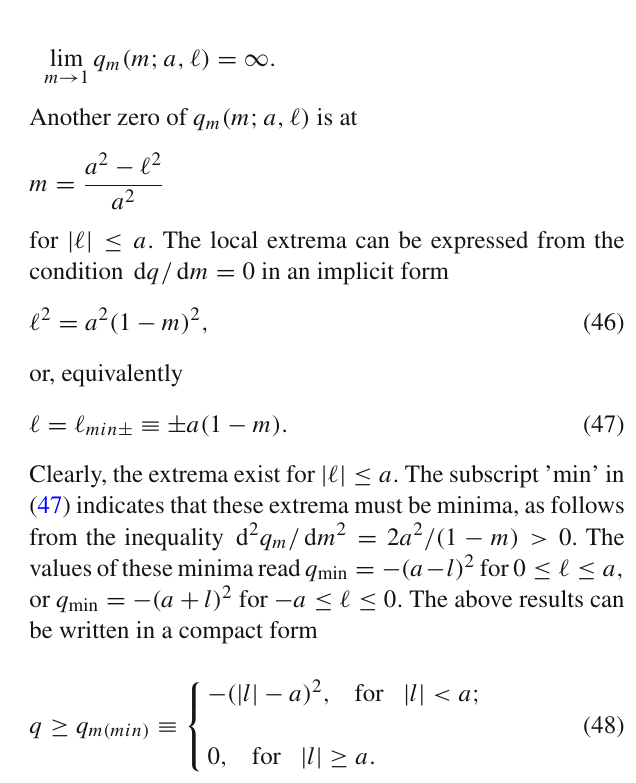
Fig. 4 Typical behaviour of the function q m ( m ; a ,(cid:11)) for appropriately chosen values of the parameter